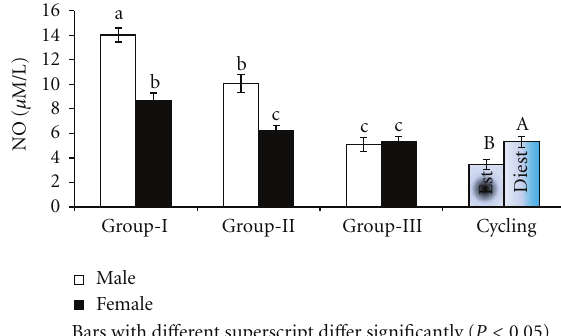
Figure 2: NO in culture supernatant supplemented with estradiol in Murrah bu ff aloes of di ff erent sex, age, and stage of cycle.